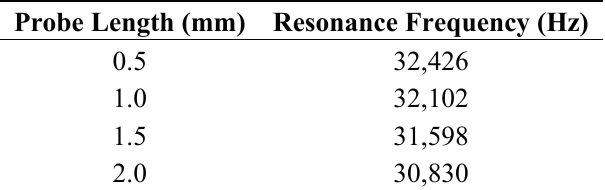
Table 8. Resonance frequency with varying probe lengths.